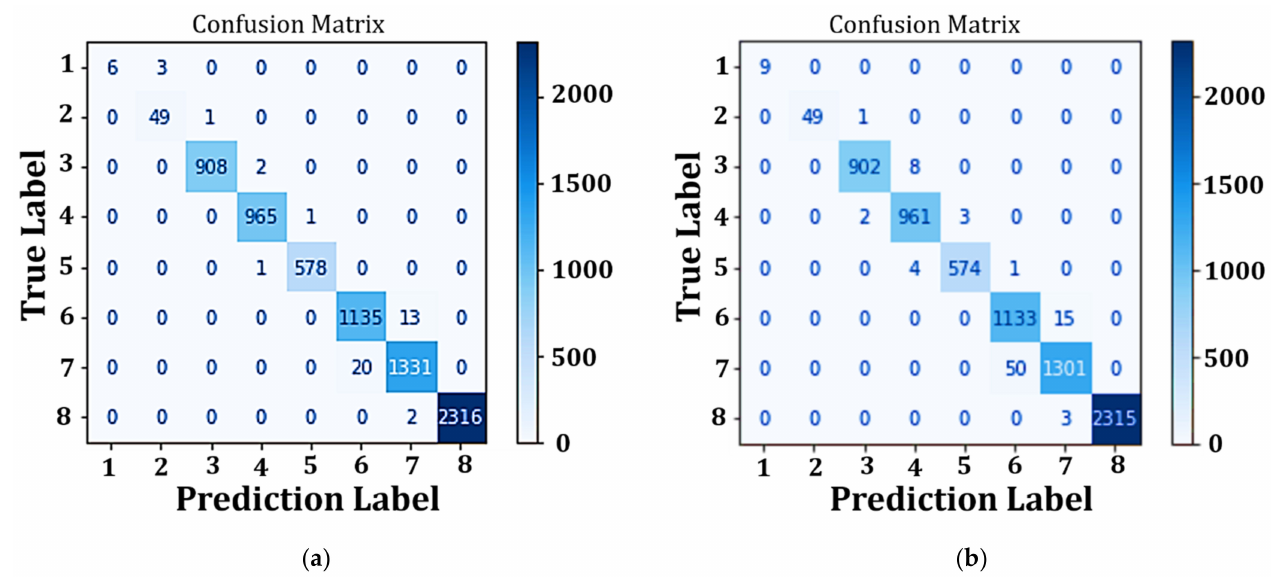
Figure 19. Confusion Metrics for: ( a ) RF-(RandomOverSampler), and ( b )